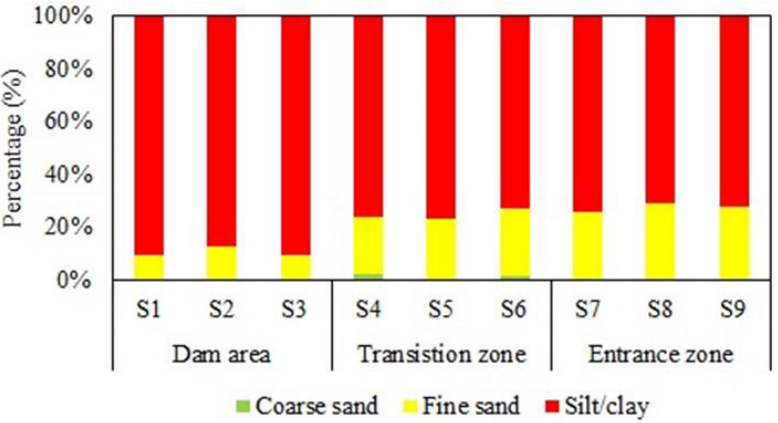
Figure 4. Particle size (%) composition of surface sediments at each sampling station (S). The graph shows the percentage of coarse sand, fine sand and silt/clay at each sampling station, divided into dam area, transition zone and reservoir’s entrance